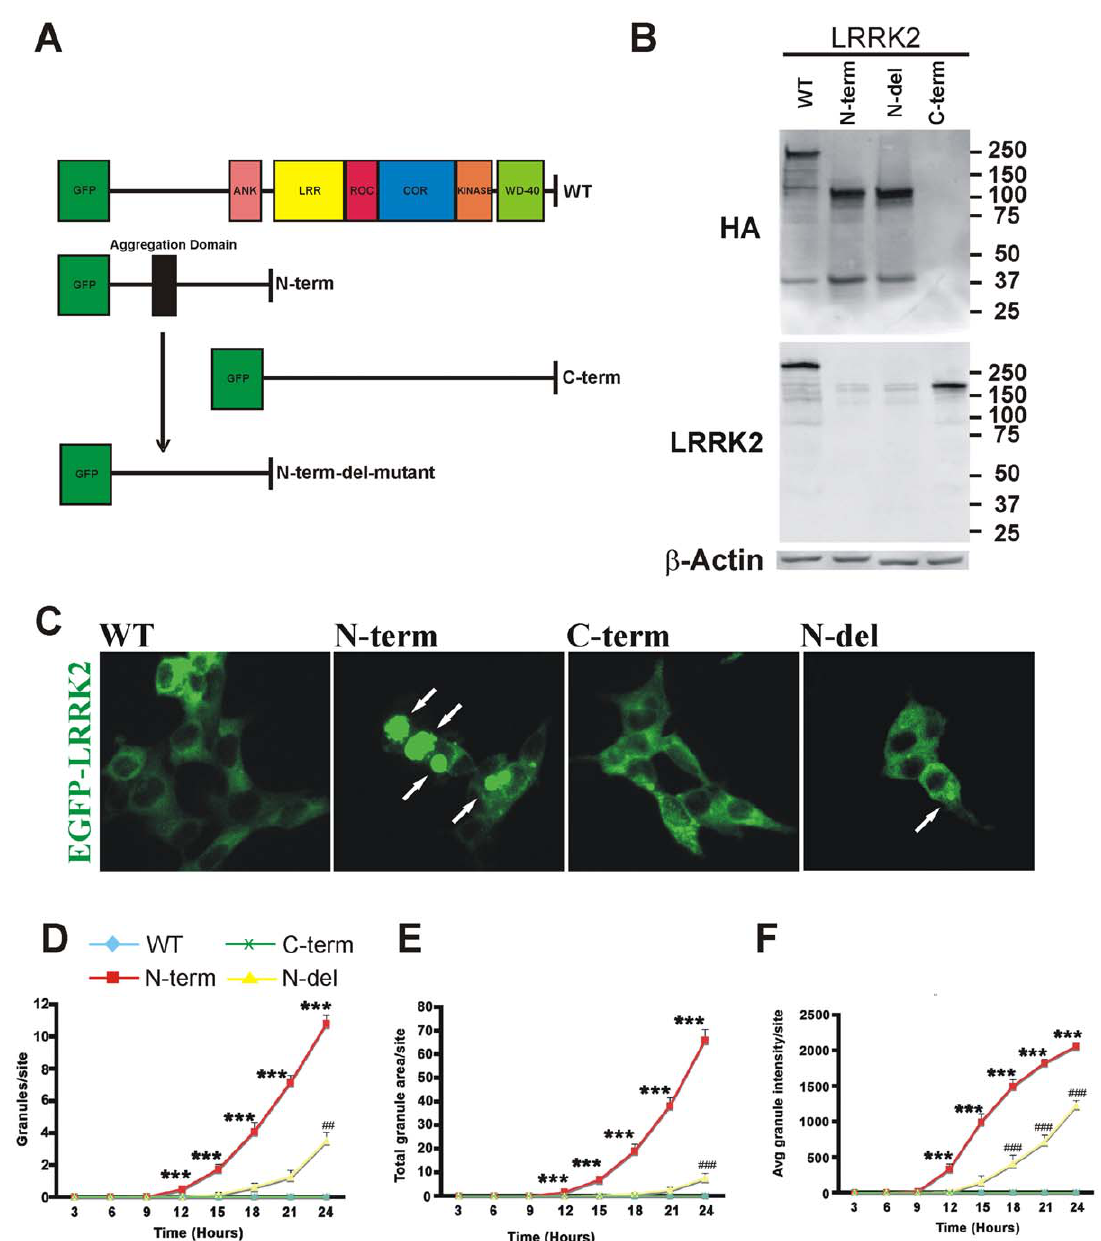
Figure 2. LRRK2 N-terminal sequences show increased aggregation. ( A ) Schematic of WT, N-term, and C-term showing locations of functional groups, EGFP tag, and bioinformatically-determined N-terminal aggregation-prone region. N-terminal deleted LRRK2 was created by the removal of 35 amino acids including the aggregation region. ( B ) Western blots of cell lysates of SH-SY5Y cells transfected with indicated LRRK2 construct showed equal expression of the LRRK2 protein with anti-HA (top panel) or anti-C-terminal- (bottom panel) LRRK2 antibody. Equal lysate loading is indicated by b -actin loading control. ( C ) EGFP-LRRK2 (WT, N-term, C-term, or N-del) constructs were transfected into SH-SY5Y cells. Representative images after 24 hours show N-term-LRRK2 cells with increased aggregates as indicated by arrows. Quantitation of granule number ( D ), granule size ( E ), and granule intensity ( F ) over 24 hour time course using ImageXpress automated acquisition and analysis system. One hundred images were analyzed per construct across 4 wells. Line graphs show the average of the mean values from each of three experiments 6 S.E.M., (*** denotes p value , 0.001 for N-term versus WT, C-term or N-del- LRRK2 construct. ### denotes p value , 0.001, ## denotes p value , 0.01 for N- del versus WT, C-term or N-term-LRRK2 construct, n=4, one-way ANOVA with Bonferroni post hoc